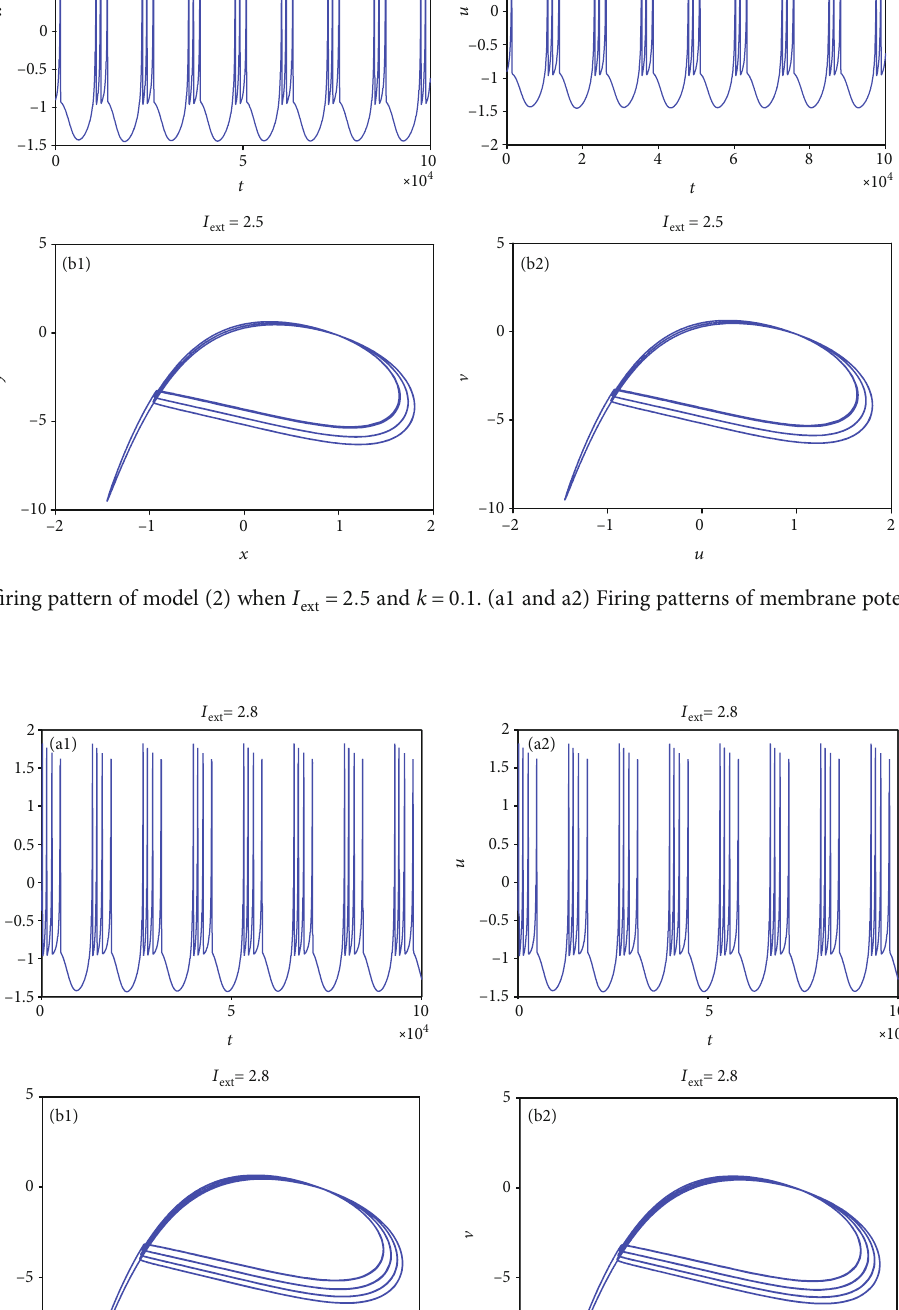
= 2 : 8 and k = 0 : 1 . (a1 and a2) Firing patterns of membrane potentials. (b1 and b2) ext